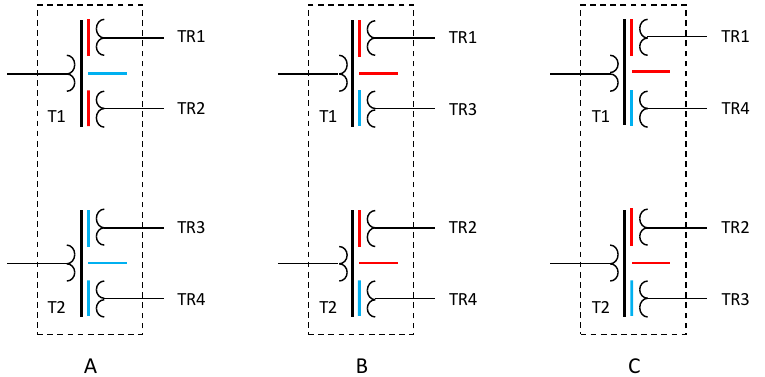
Figure 3. Gate driver power transmission configurations using two transformers with CS arrangement.